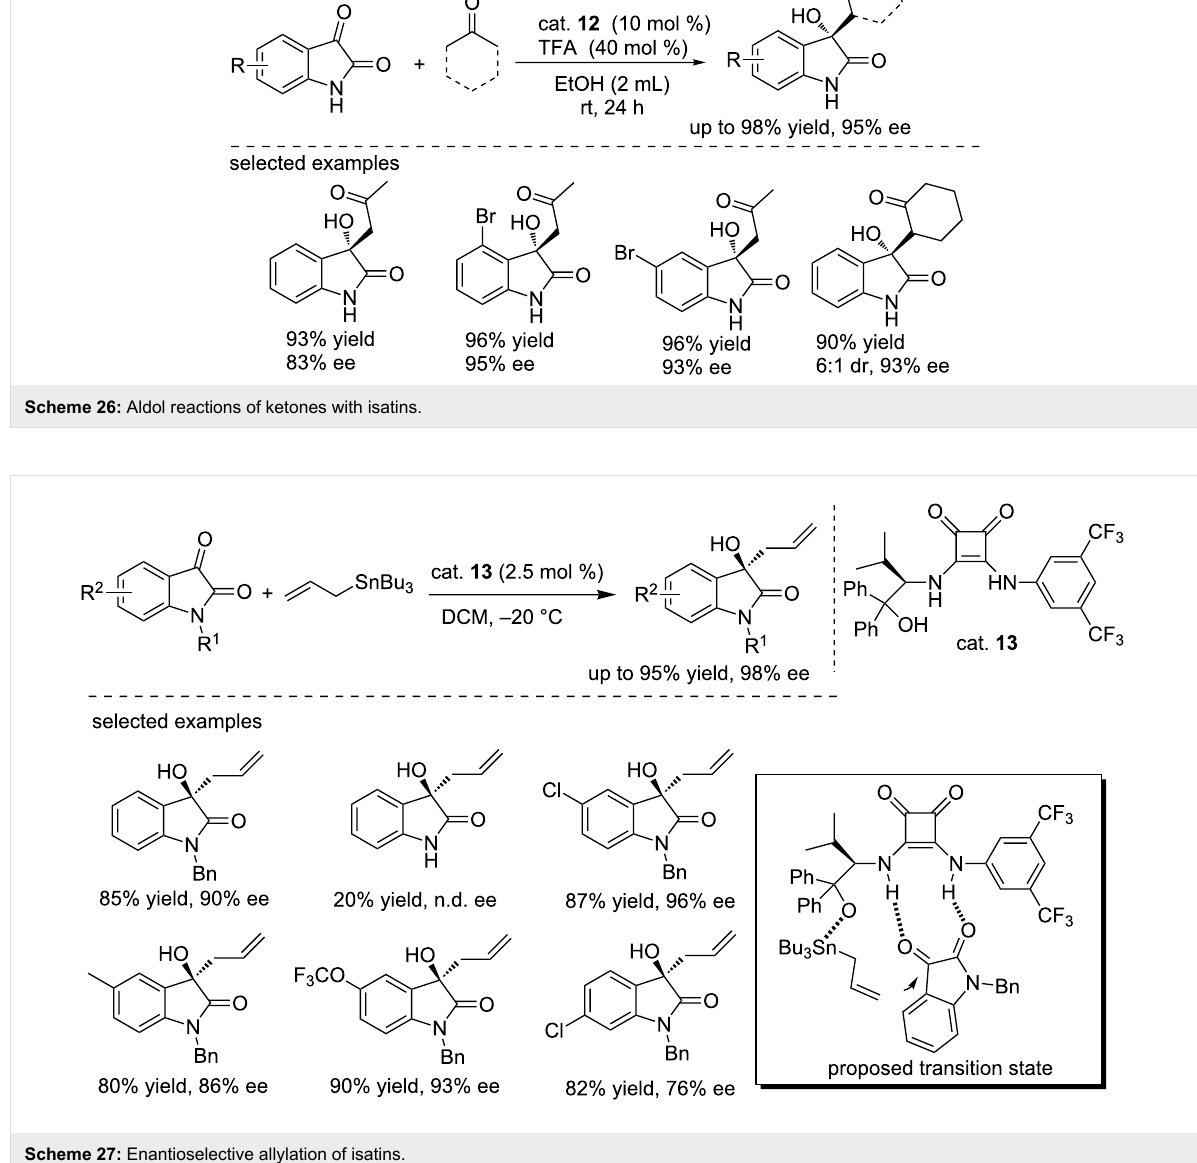
Scheme 27: Enantioselective allylation of